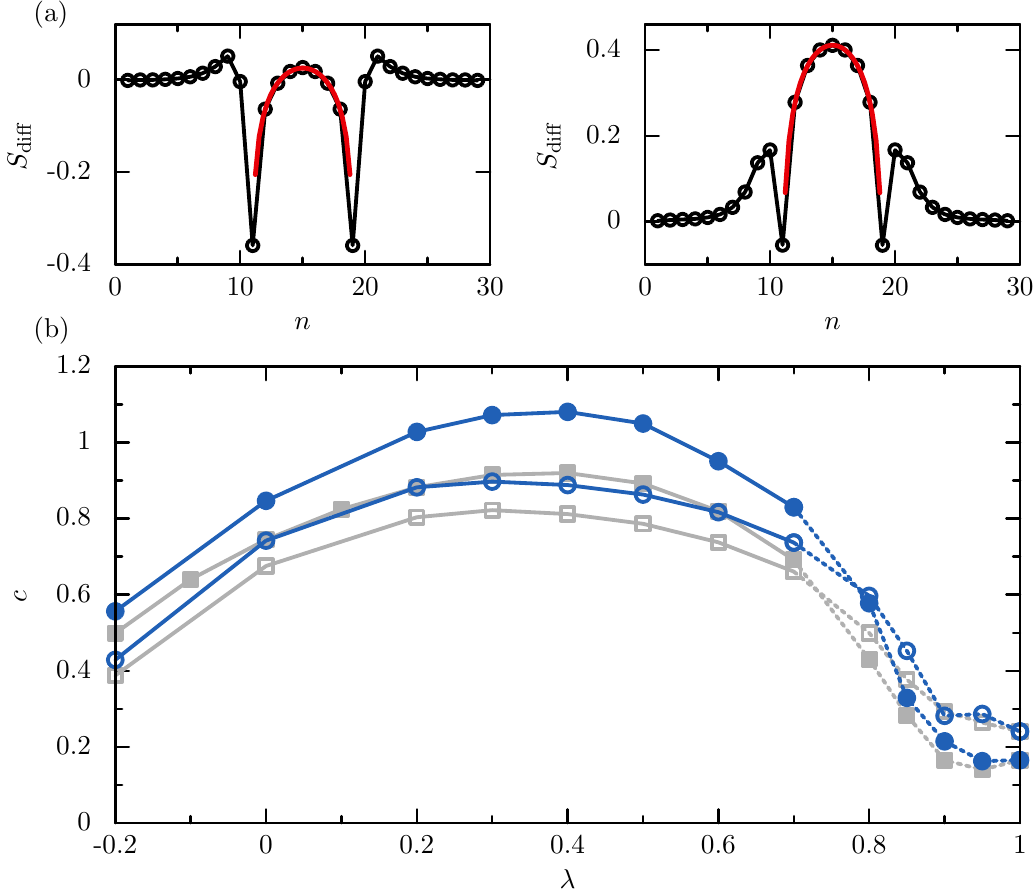
Figure 11: (a) Increase in von Neumann entropy after insertion of two static charges ± 1 in distance (cid:96) = 9 on a 30 × 10 lattice. Entropies taken at vertical cuts of the cylinder between sites n , n + 1. Between the charges, a Calabrese–Cardy fit (red) yields a central charge c as shown for λ = − 0.2 (left) and λ = 0.7 (right). (b) Central charges c over coupling parameter λ for system sizes 24 × 8 (grey boxes) and 30 × 10 (blue points), (cid:96) = 5 (open) and (cid:96) = 9 (filled symbols). For λ ∈ [ 0.7,1 ) (dashed lines), resonant plaquettes on both sublattices where found in superposition when charges where present, increasing the entanglement entropy compared to the system without charges. For λ = 1, exact ground state results are shown. Bare fit-errors are smaller than point